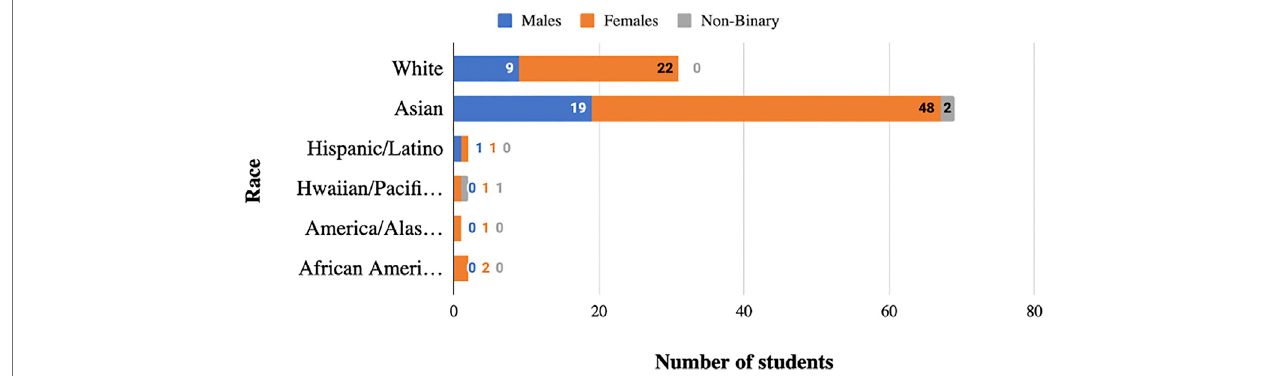
FIGURE 2 | Demographic summary of participants (N (cid:1) 107) that completed our survey.